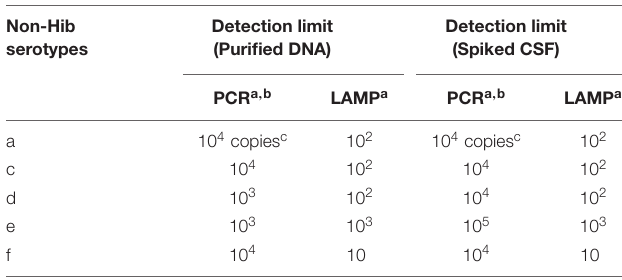
TABLE 3 | Detection limits of LAMP and PCR assays detecting DNAs of non-Hib serotypes and using the DNA spiked CSF specimens. Non-Hib